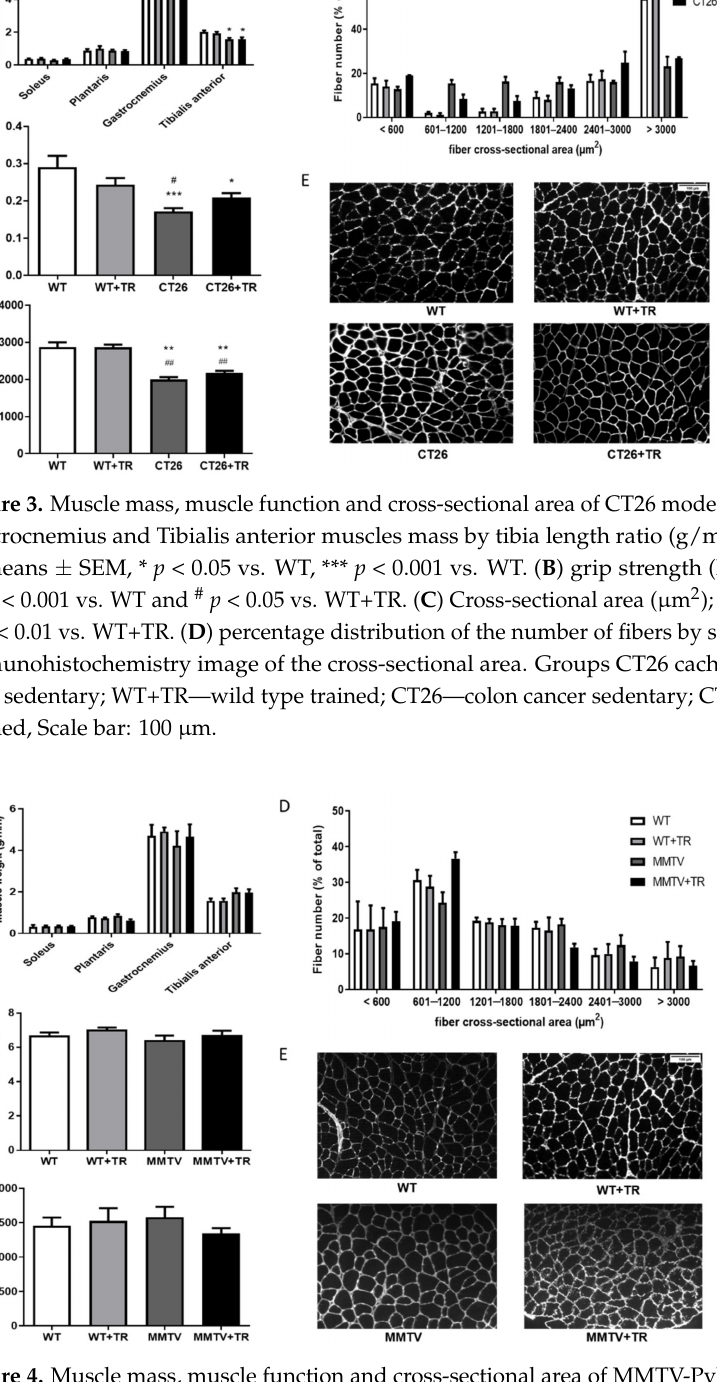
Figure 4. Muscle mass, muscle function and cross-sectional area of MMTV-PyMT model. ( A ) Soleus, Plantaris, Gastrocnemius and Tibialis anterior muscles mass by tibia length ratio (g/mm). ( B ) Stride length (cm). ( C ) Cross-sectional area ( µ m 2 ). ( D ) percentage distribution of the number of fibers by size. ( E ) Demonstrative Immunohistochemistry image of the cross-sectional area. Groups: WT—wild type sedentary; WT+TR—wild type trained; MMTV—mammary cancer sedentary; MMTV+TR—mammary cancer trained, Scale bar: 100 µ